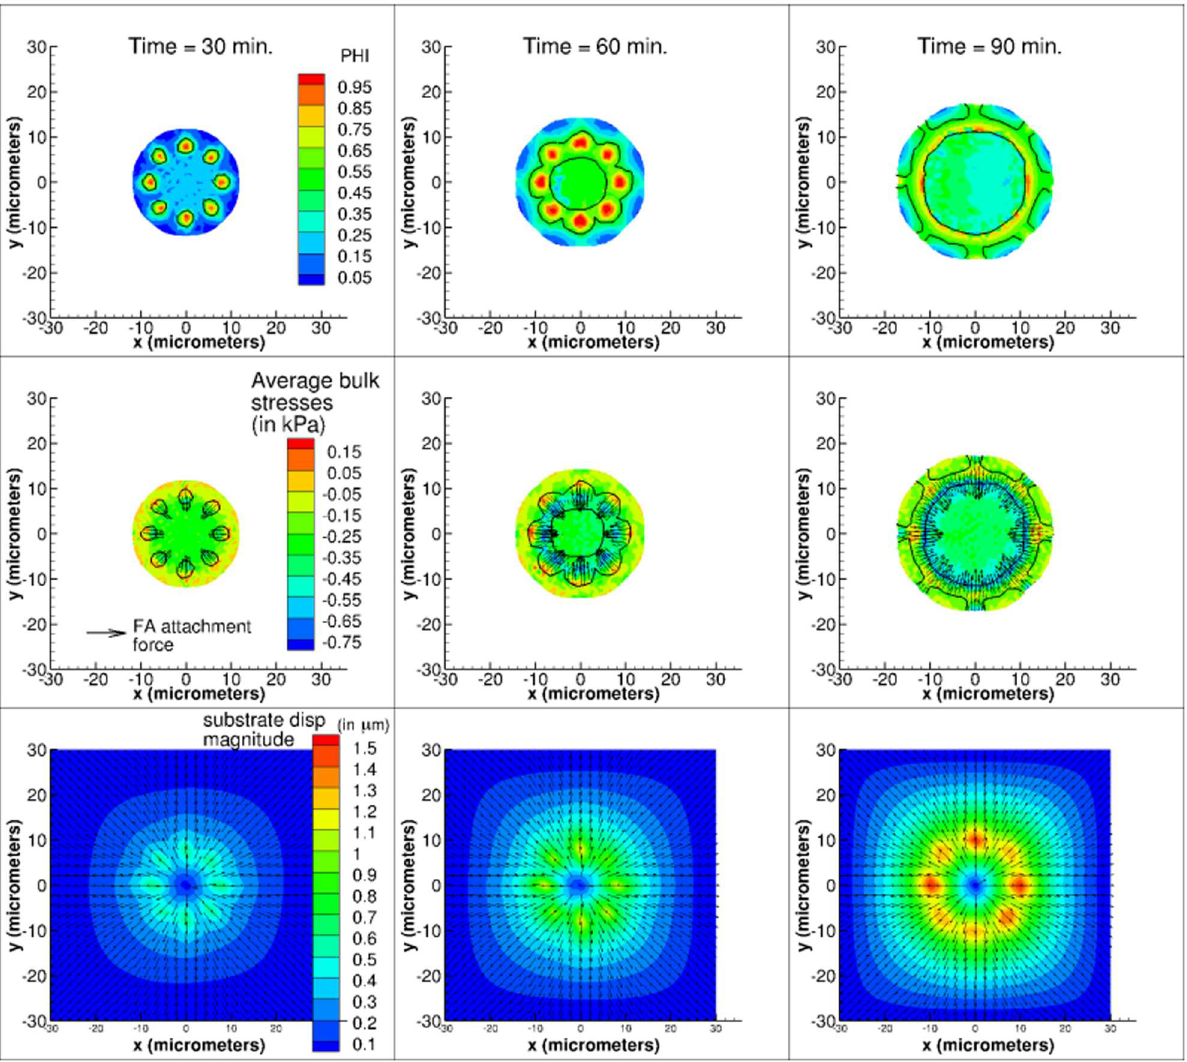
Fig 8. Spatiotemporal evolution of ϕ (top row), cell stress (middle row), and substrate displacement (bottom row) at time = 30, 60, 90 min. FA-cell area critical ratio: 30%; E s = 2.5 kPa; No FA breakage. Black outlines indicatethe location of the FAs. Vectors in cell stress contour graphs(middle row) show direction of forces arisingfrom FA attachments. Note that as the cell spreadsthese forces are oriented toward the cell center.